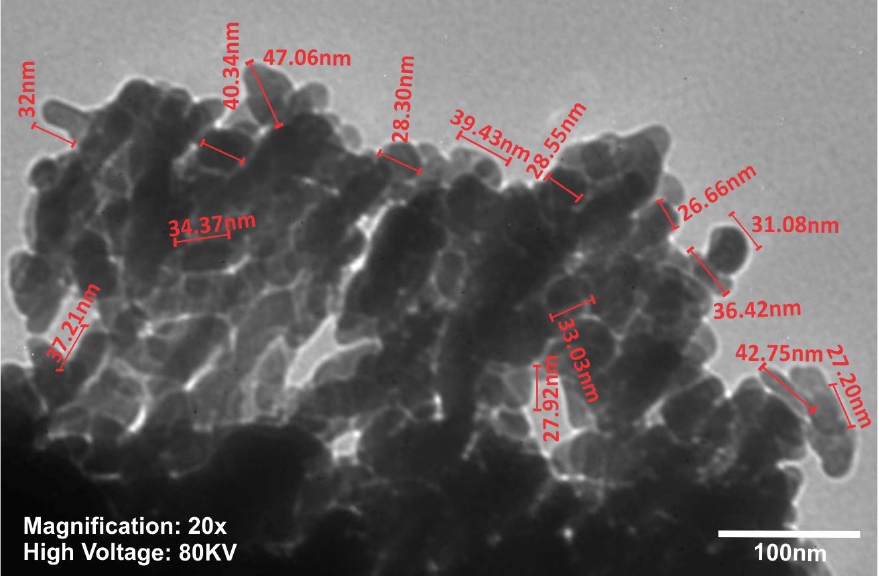
Figure 3. TEM image of the synthesized nHAP powder. Materials 2021 , 14 , x FOR PEER REVIEW